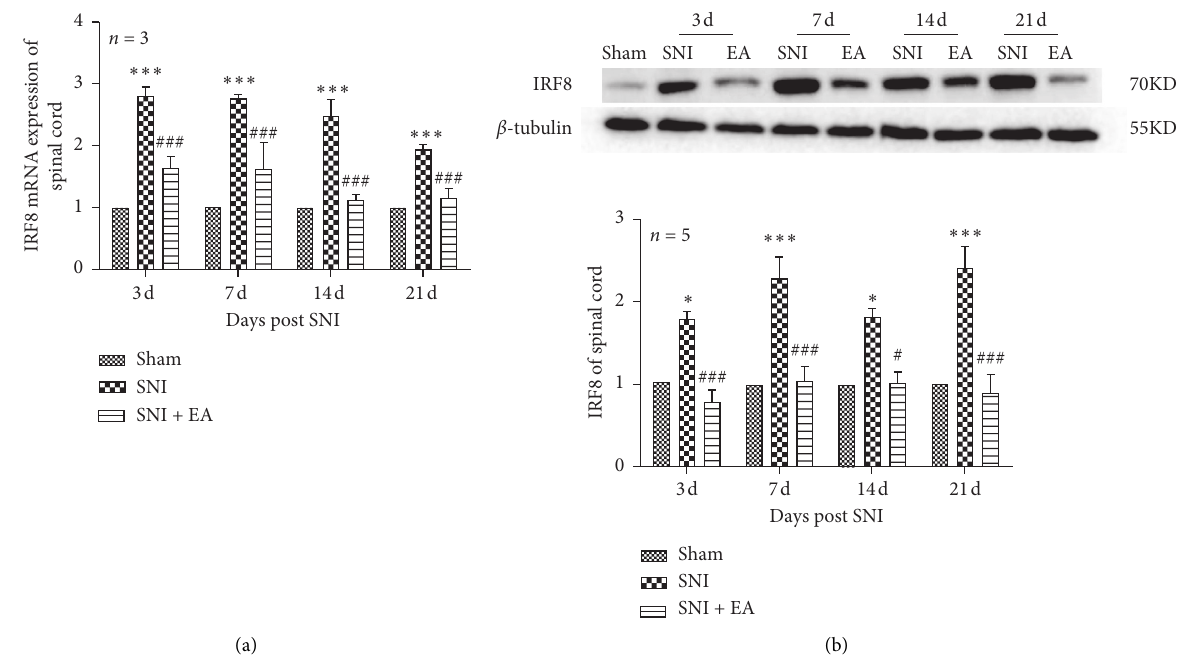
Figure 3: Effect of 2Hz EA on spinal IRF8 expression in SNI rats. (a) Relative level of IRF8 mRNA expression. (b) Western blotted band of IRF8 and relative level of IRF8 protein expression. Samples were collected from the L4-L6 segments of the spinal cord on days 3, 7, 14, and 21 postsurgery. ∗ P < 0 . 05, ∗∗∗ P < 0 . 001, compared to the sham group; # P < 0 . 05, ### P < 0 . 001, compared to the SNI group. All data were expressed as the mean ± SEM, n � 3–5 per group. Two-way repeated-measures ANOVA followed by Bonferroni’s post hoc